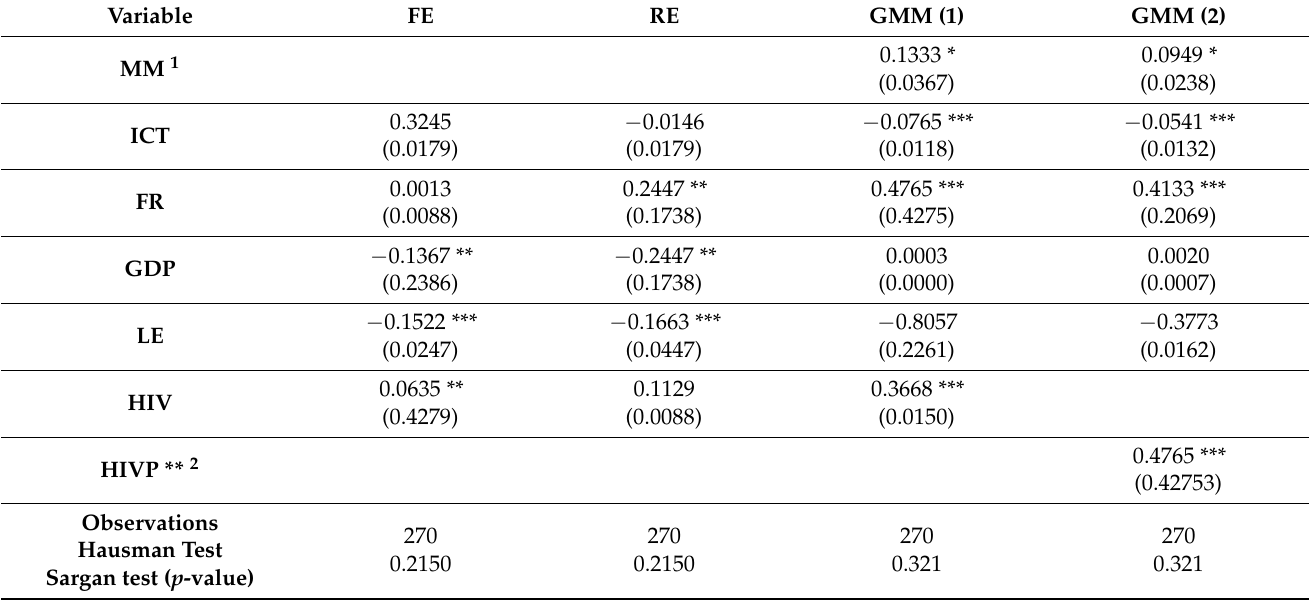
Table 7. Regression results. Dependent variable: